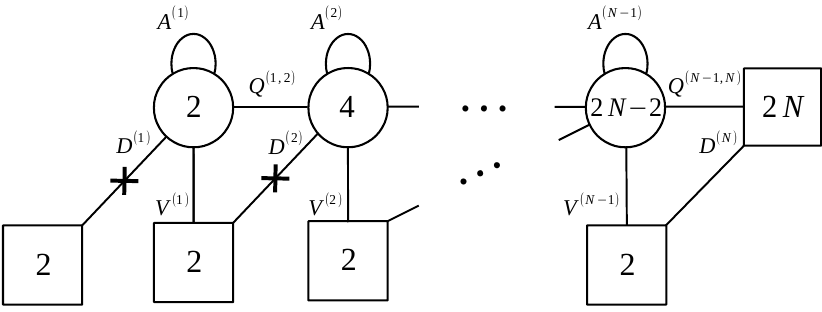
Figure 14 . The quiver diagram for E [USp(2 N )] . The crosses represent the singlets b j that flip the diagonal